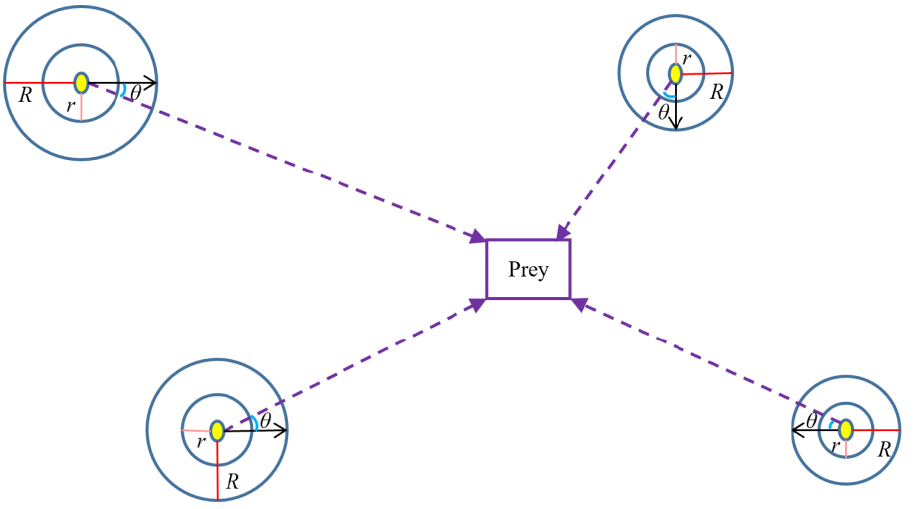
Figure 1. Schematic diagram of hunting stage in SCSO.